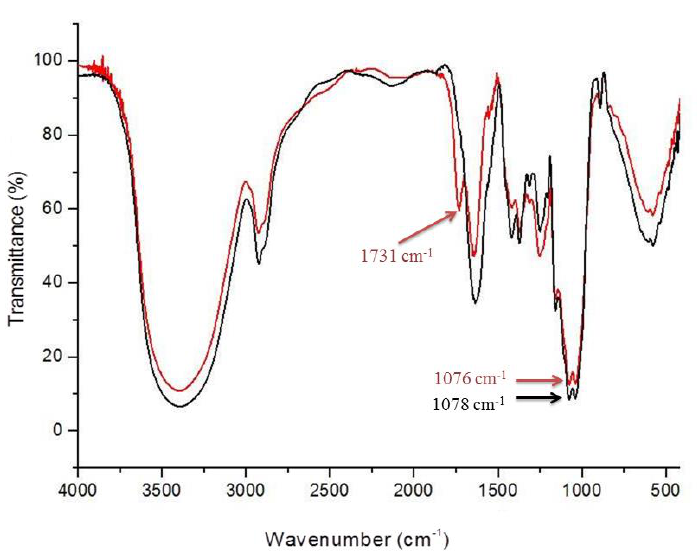
Figure 5. Infrared spectra of LM (in black) and LMG (red). Table 2. Infrared spectra of LM and LMG (positions of the peaks*).